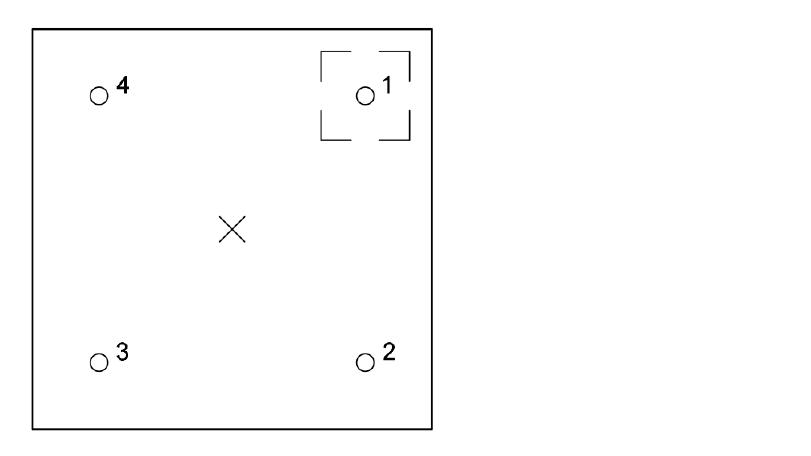
Figure 9. Scheme of void and IE device layout, void below sensor 1. Table 4. Integral and RMS of frequency spectrum, void below sensor 1.